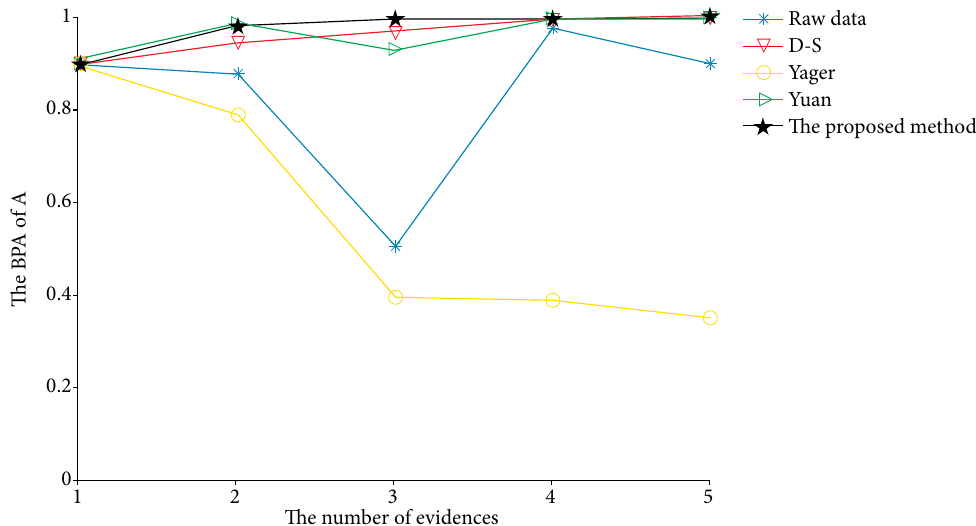
Figure 2. Comparison of evidence fusion results for various method with normal evidence, example 1.